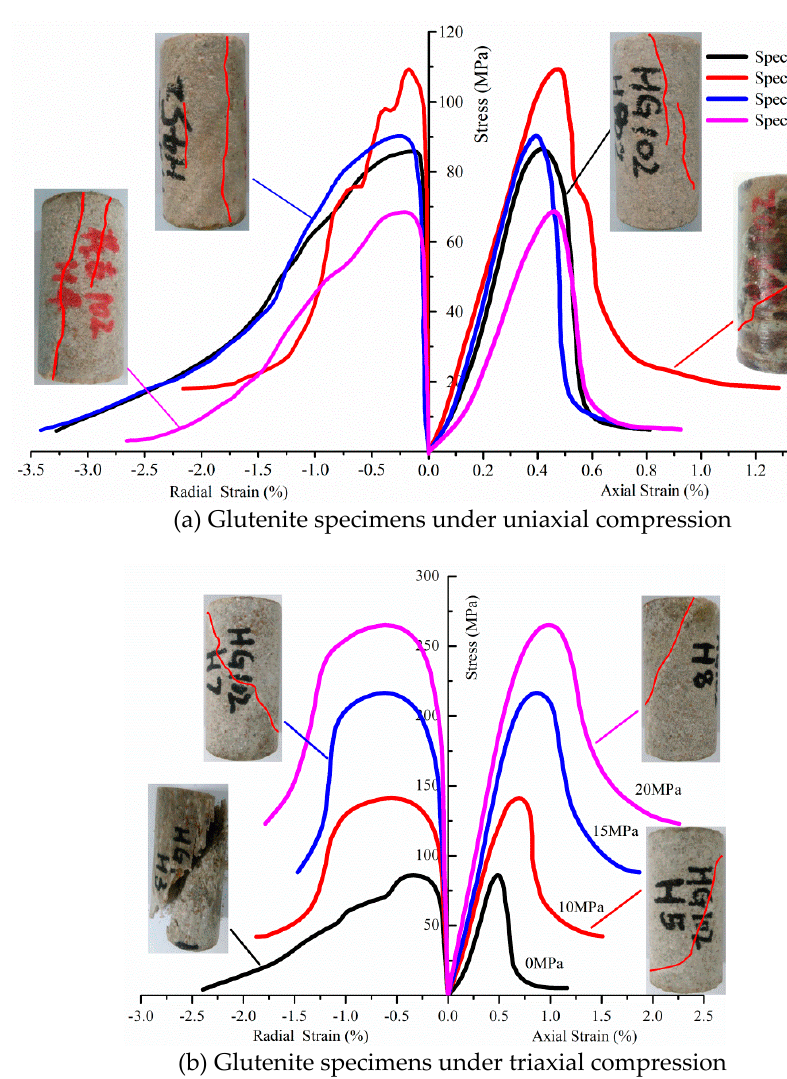
Figure 7. Stress–strain curves and fracture morphology of glutenite specimens under ( a ) uniaxial and ( b ) triaxial compression.